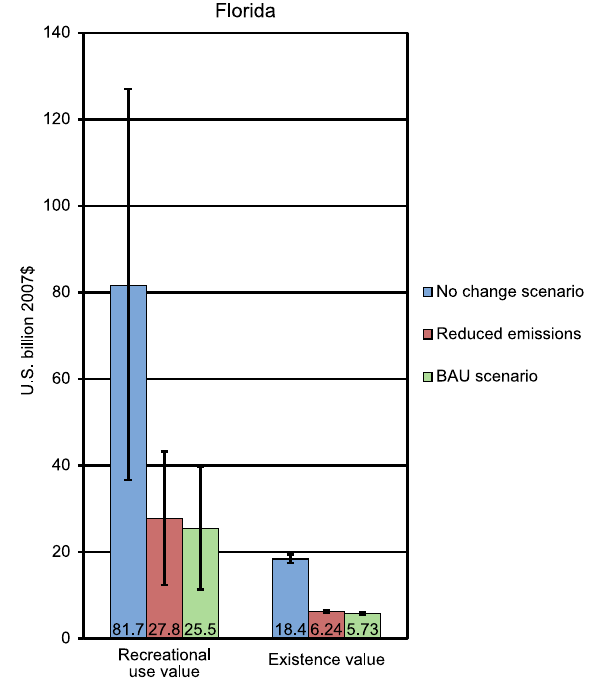
Figure 2. Economic values (with 95% confidence interval) for BAU and reduced emission scenarios for Florida.